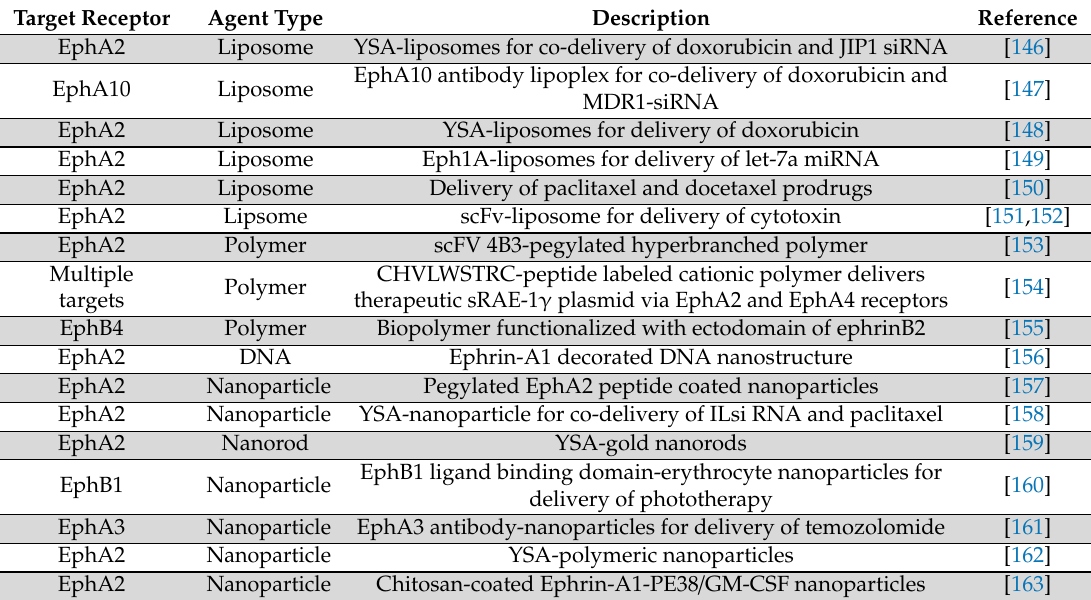
Table 2. Engineered delivery systems designed to improve target